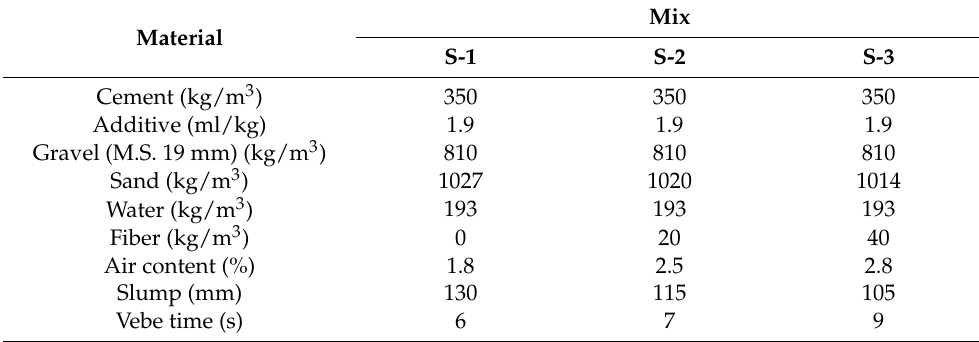
Table 1. Mixture composition.